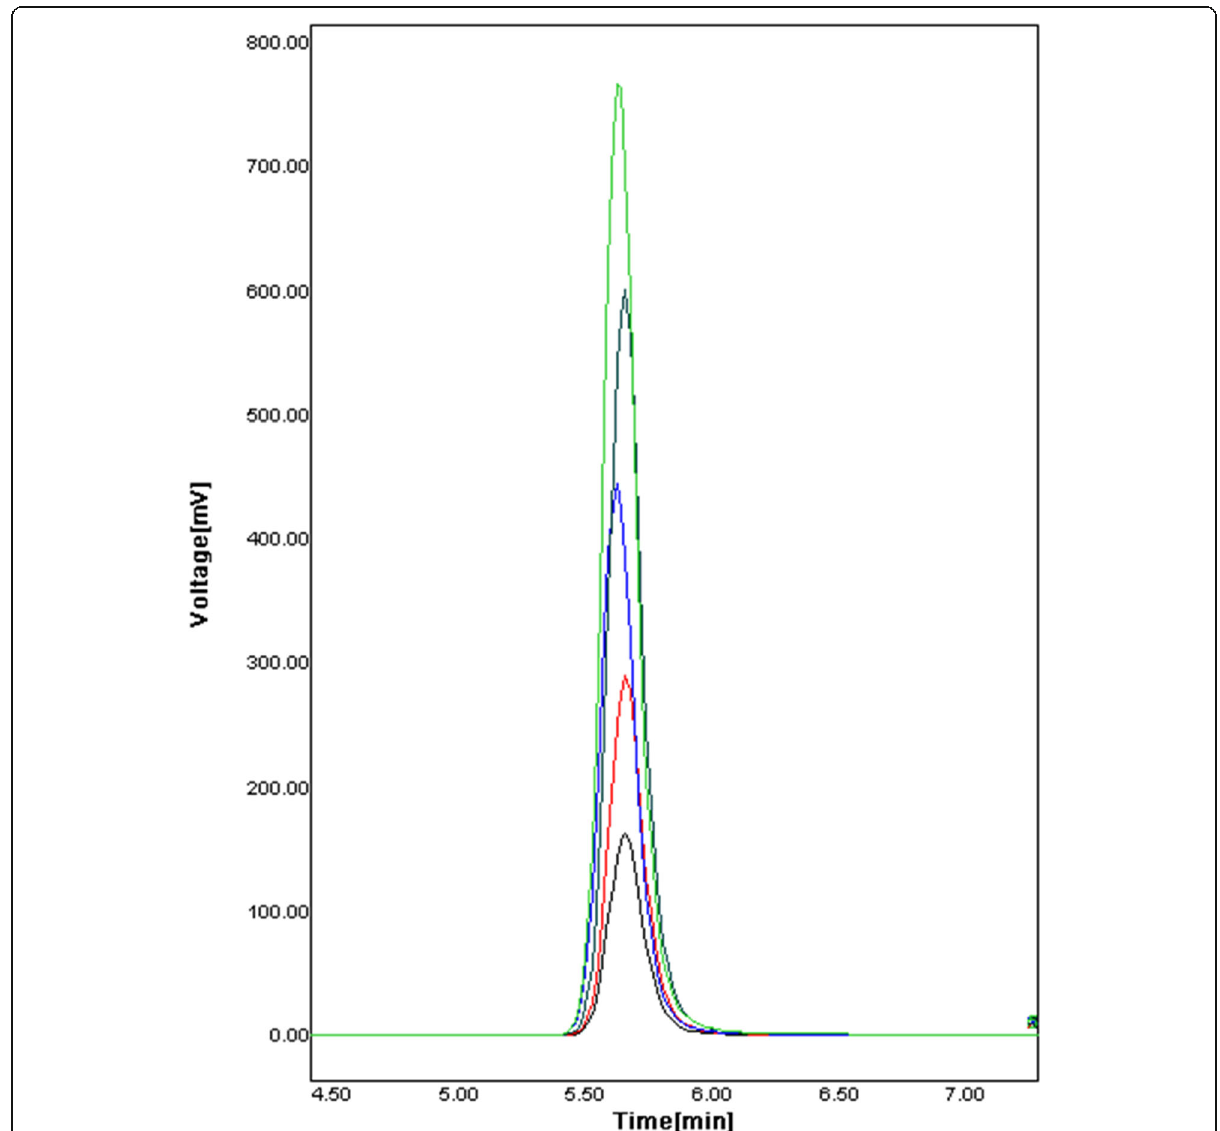
Fig. 6 Overlay of chromatograms of 10, 20, 30, 40, and 50 μ g/ml of